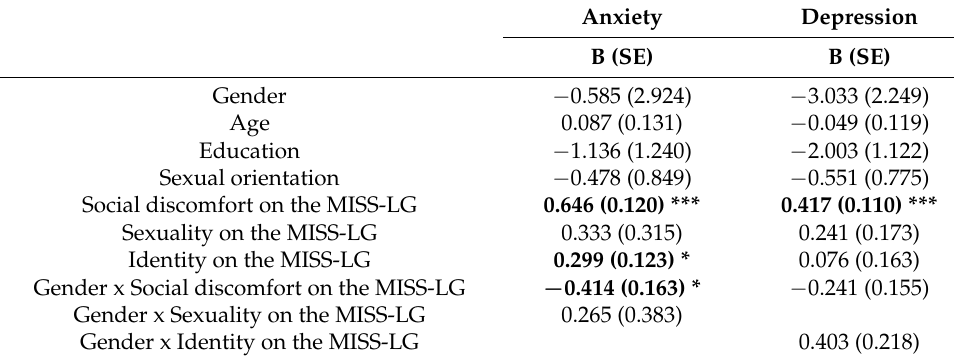
Table 5. Moderating effects of gender on the associations of internalized sexual stigma with anxiety and depression: Multivariate linear regression